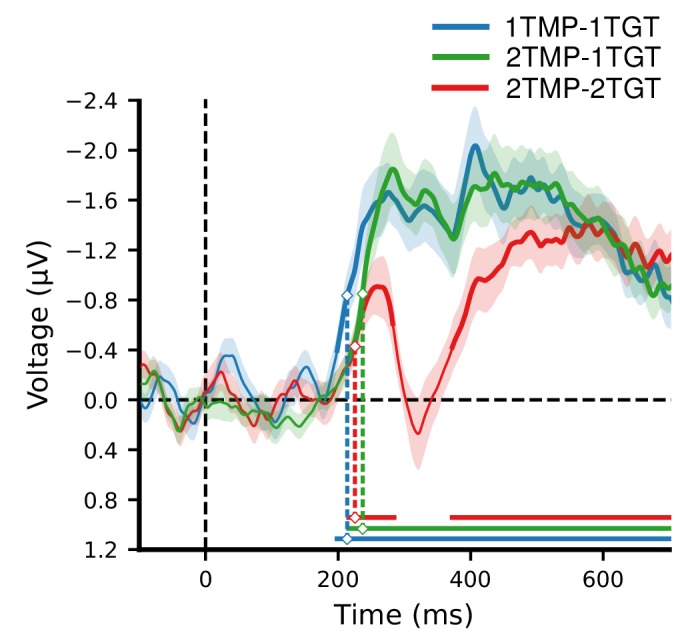
Average N2pc difference waves for targets on the horizontal (left vs. right) meridian as a function of number of templates and number of target features.N2pc components were computed using the electrodes PO7 and PO8, by subtracting ERPs ipsilateral to the visual field of lateral targets from contralateral ERPs. The shaded area represents 1 SEM above and below the mean for every time point. Thick lines and horizontal bars indicate significant clusters (at α = 0.05) as produced by cluster-based permutation testing (5000 permutations). For visualization purposes only, the contra-ipsilateral difference waves over time were fitted with a cubic spline (λ = 15, comparable to a 30 Hz low-pass filter) to achieve temporal smoothing. Note the statistical analyses and estimation of the onset latencies were done on unsmoothed data. The marked time points indicate the latency of 50% maximum amplitude as estimated using a jackknife approach, as a measure of the onset of selection (Miller et al., 1998; Luck, 2014; Liesefeld, 2018). Reliable N2pc and sustained posterior contralateral negativity (SPCN; Mazza et al., 2007; Jolicoeur et al., 2008; Eimer, 2014; Grubert et al., 2016) components were identified in all three conditions. Onset latency was fastest for the 1TMP–1TGT condition (214 ms), followed by the 2TMP-2TGT condition (225 ms), and, surprisingly, the 2TMP–1TGT condition (237 ms, all ts > 2.2, ps<0.05). Although overall patterns are similar, these findings indicate that our main classification analyses reflect more information than is present in just the N2pc, which is subject to inherent electrode selection. See also Figure 2—figure supplements 1—source data 1.10.7554/eLife.49130.007Figure 2—figure supplement 1—source data 1.Time series data of N2pc difference wave locked to stimulus display onset for each condition separately.